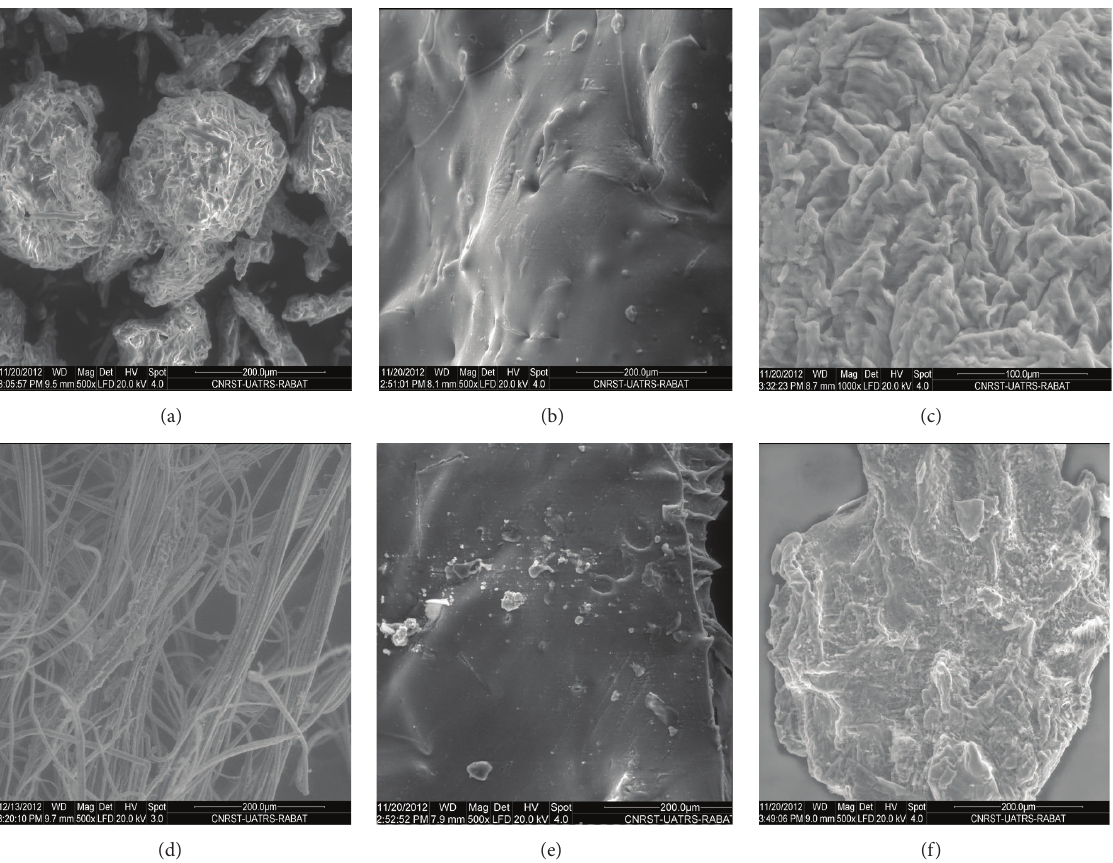
Figure 4: SEM micrographs of microcrystalline cellulose (a), regenerated microcrystalline cellulose (b), grafted microcrystalline cellulose (c), kraft cellulose (d), regenerated kraft cellulose (e), and grafted kraft cellulose